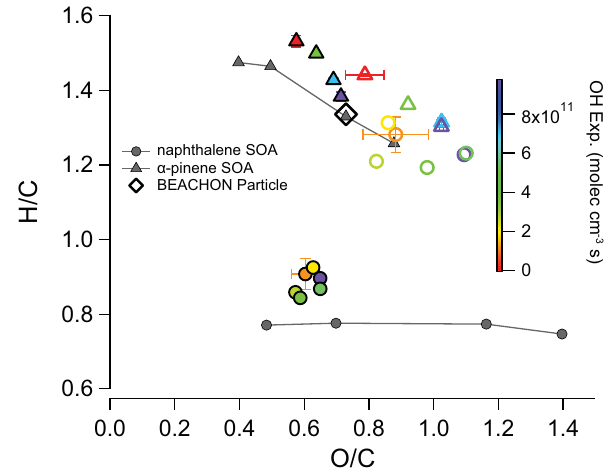
Figure 8. Average O / C and H / C ratios for extracted particle- phase (solid colored markers) and gas-phase (outlined colored markers) acetate-CIMS spectra (at C OA = 10µgm − 3 ) as a func- tion of OH exposure. Gray points represent AMS elemental ratios from Lambe et al. (2011a). Average particle-phase elemental ra- tios from the BEACHON-RoMBAS field campaign obtained from MOVI-HR-ToF-CIMS measurements are depicted by a black dia- mond (Yatavelli et al., 2014; Ortega et al., 2014). Error bars repre- sent 1 standard deviation for multiple